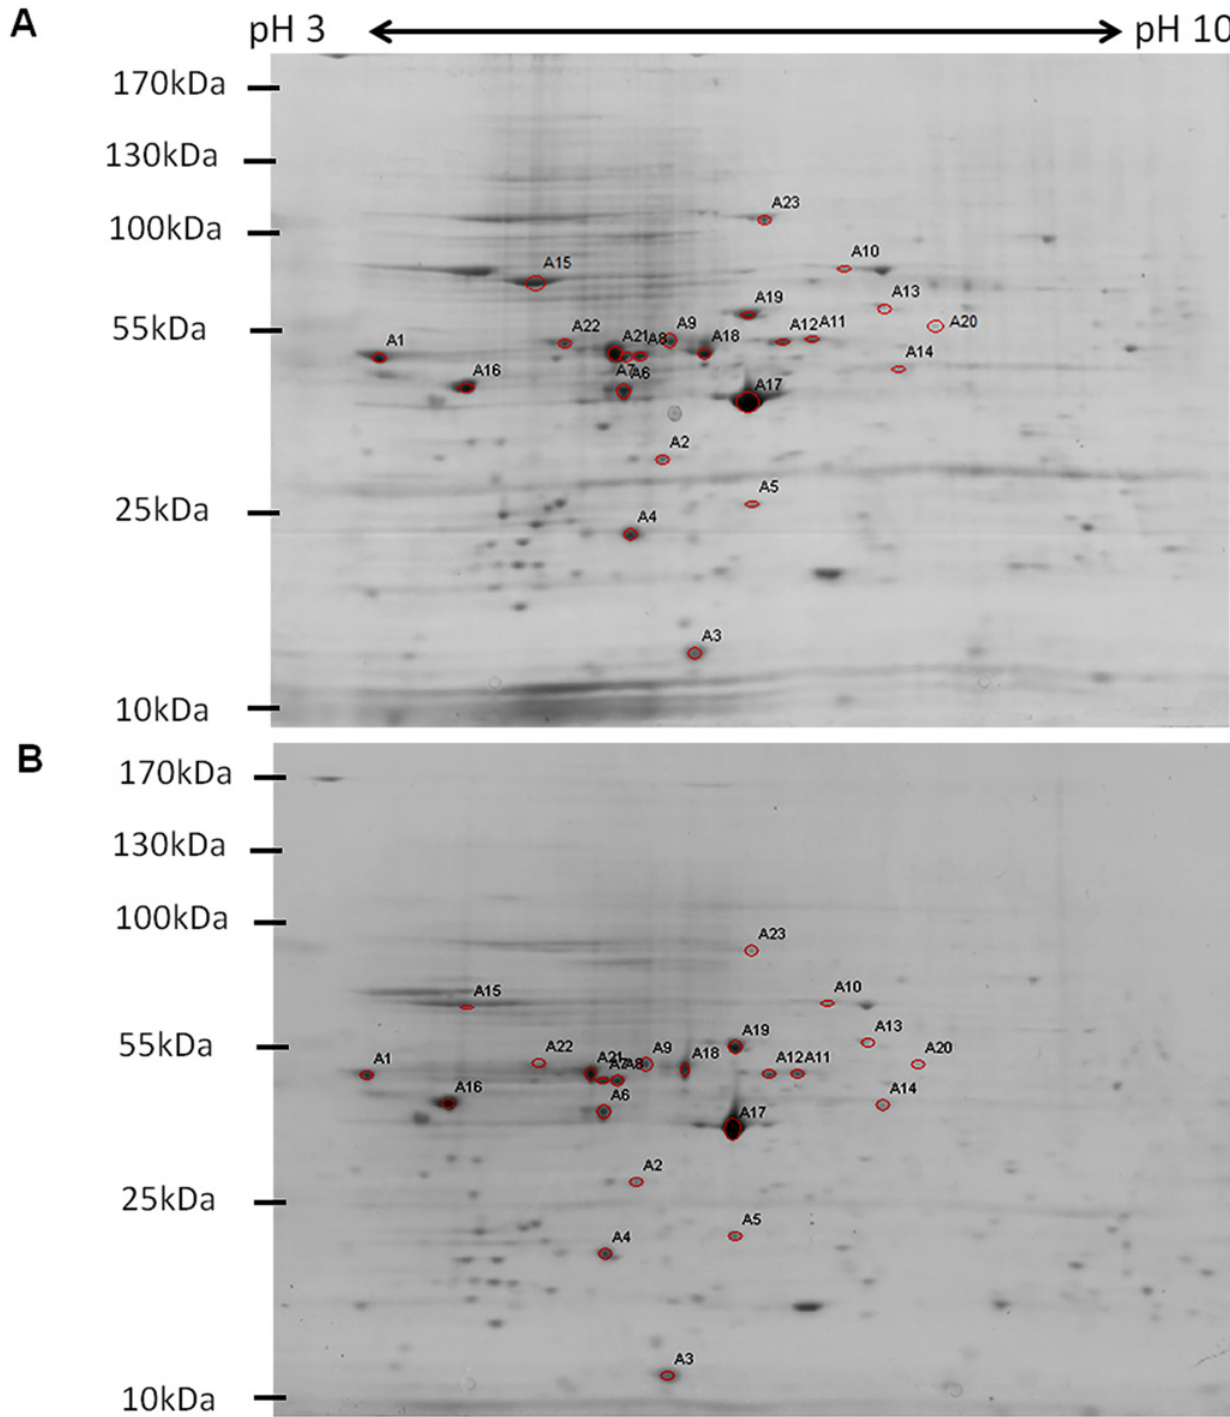
Fig 1. 2DE analysis of CHIKV-infected C6/36 cells. (A) Twenty-three protein spots of mock-infected samples that showed 2-folds changes with p < 0.05 (Student ’ s t -test) as compared to (B) CHIKV-infected samples were annotated. All the SDS-PAGE gels from the second dimension separation were analyzed using PDQuest 2-D Analysis Software (BioRad). Two biological replicates of the CHIKV-infected samples from each time-point infection were grouped and compared against to the corresponding biological replicates of the mock-infected samples. Representative gels are from 24h mock-infected and 24h CHIKV- infected